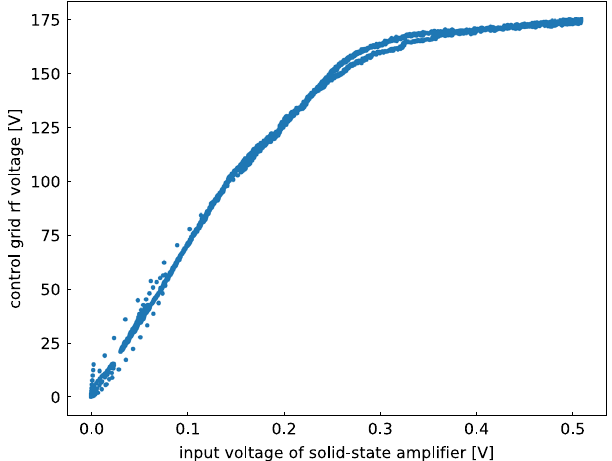
FIG. 5. Measured dependency of the control grid voltage on the input of the solid-state amplifier when accelerating the 1 MW equivalent